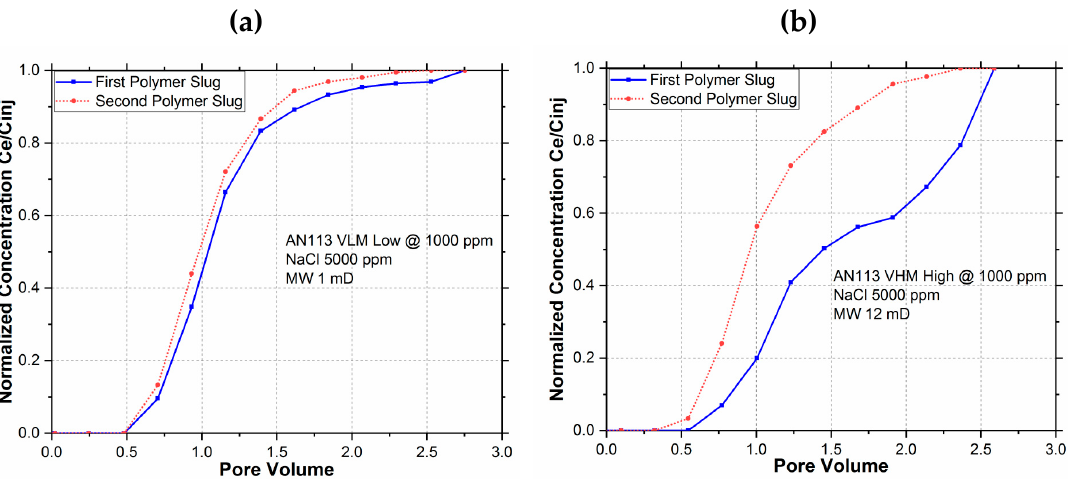
Figure 2. Breakout curves for 1000 ppm polymer concentration and 5000 PPM NaCl salinity for: ( a ) AN113 VLM (M W = 1 mD) and ( b ) AN113 VHM (12 mD).